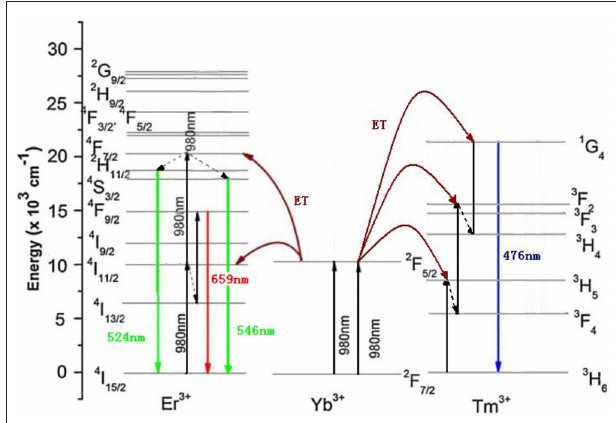
FIGURE 12 | Schematic diagram of energy levels of GdAlO 3 : Er 3 + , Yb 3 + , Tm 3 + and possible transitions under 980nm excitation (ET: energy